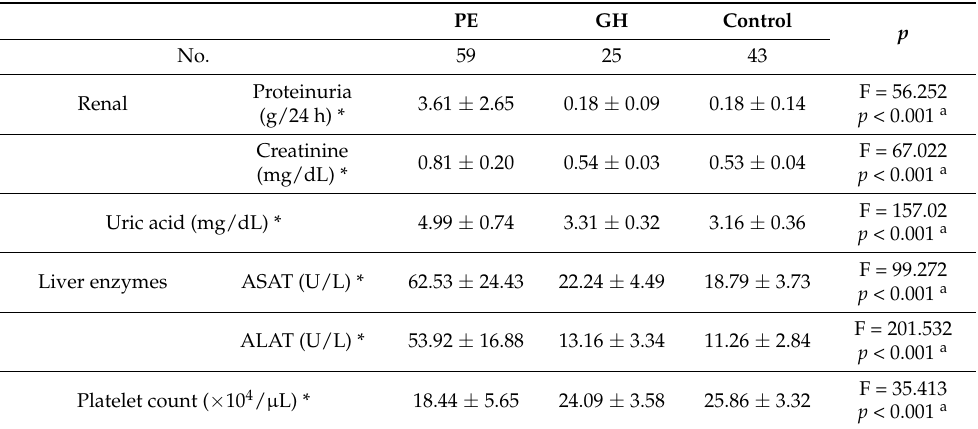
Table 2. Paraclinical findings in the studied groups.